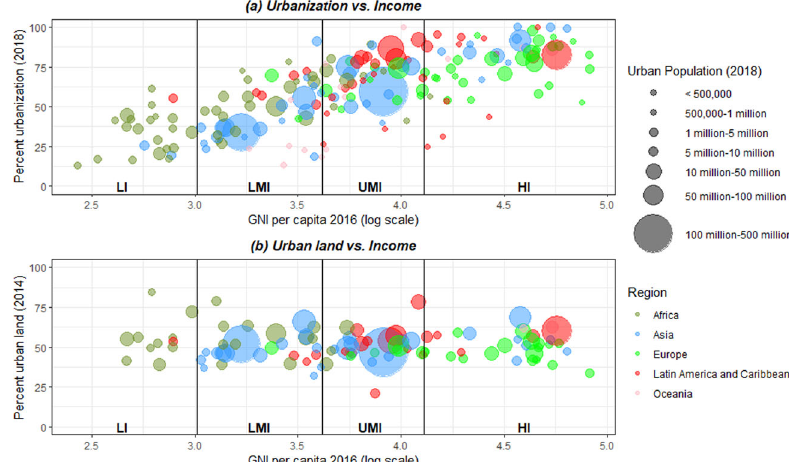
Fig. 3 Association of income levels with urbanization and urban land. a Urbanization and per capita national income (adapted from UN DESA 28 ), and b Urban land and per capita national income (GNI). Urban de fi nitions used to calculate percent urbanization are country speci fi c and listed on the UN website (https://population.un.org/wup/). Each dot represents a country, and the size of the dot is shown by the population for the same in 2018. Percent urban land is calculated from Global Human Settlement Layer (GHSL 2014) dataset as the share of impervious surface to the total urban footprint.